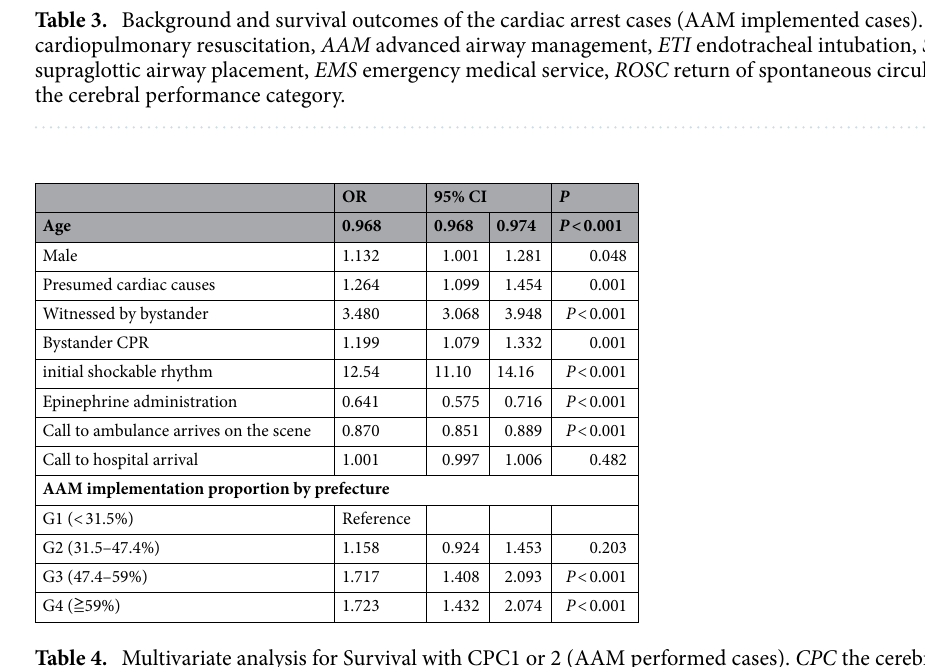
Table 4. Multivariate analysis for Survival with CPC1 or 2 (AAM performed cases). CPC the cerebral performance category, OR odds ratio, CI confidence interval, CPR cardiopulmonary resuscitation, AAM advanced airway